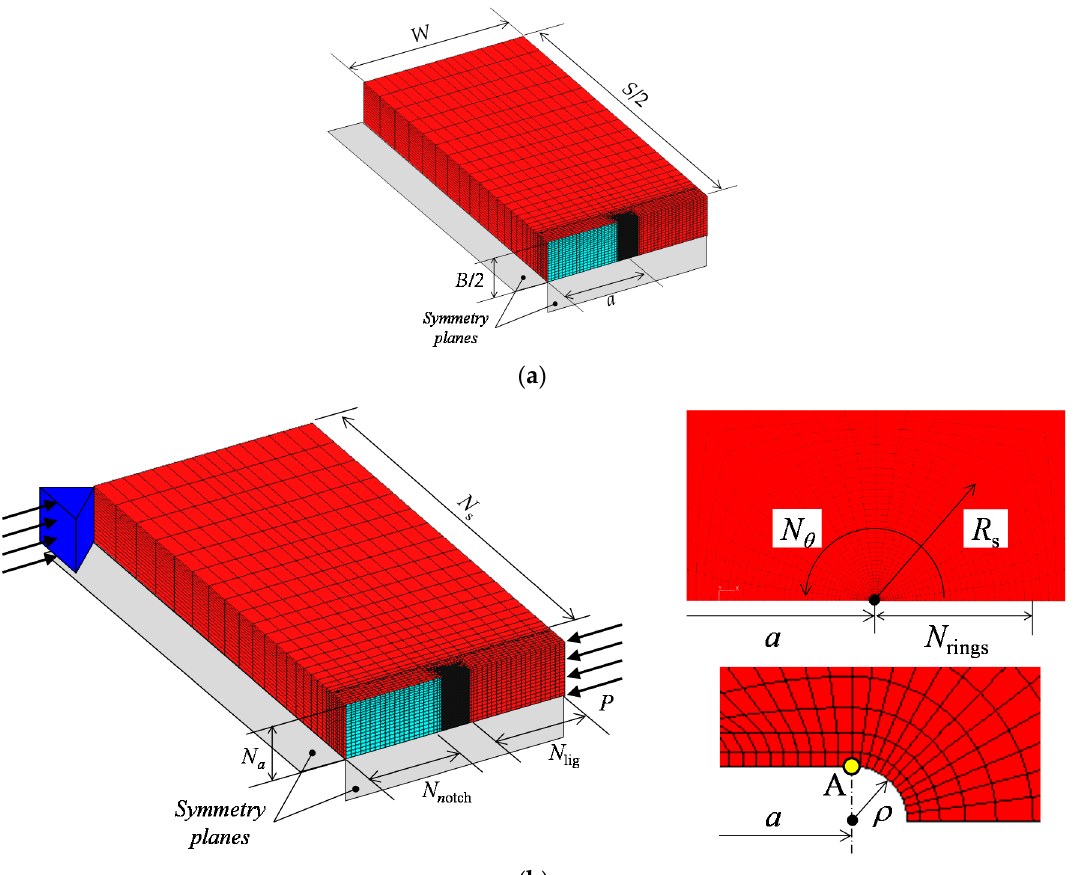
Figure 3. Definition of mesh division parameters summarized in Table 1. ( a ) Specimen geometry; ( b ) Definition of element subdivision. Table 1. Mesh division parameters of the finite element (FE) model of HT780 single-edged notched bend bar (SE(B)) specimens .